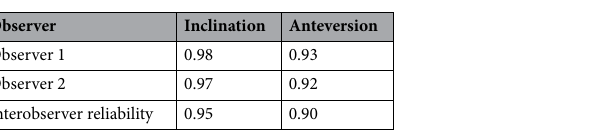
Table 1. The ICC value of observers’ measurement data of acetabular cup’s anteversion and inclination.